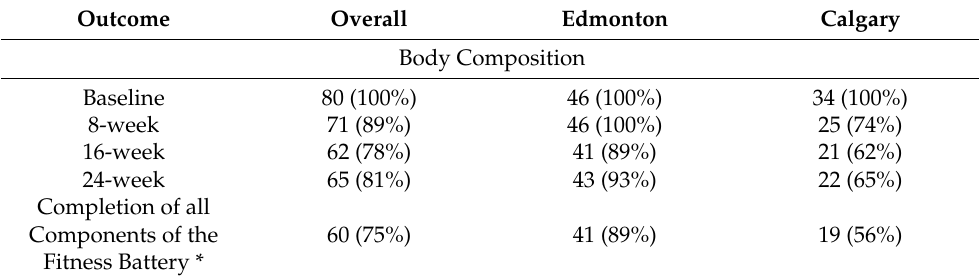
Body Composition